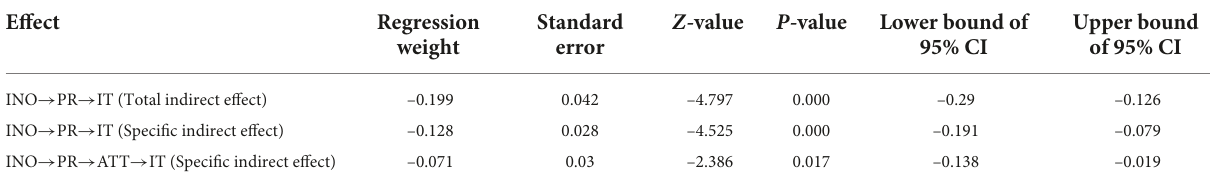
TABLE 8 Analysis of the indirect and total effects.